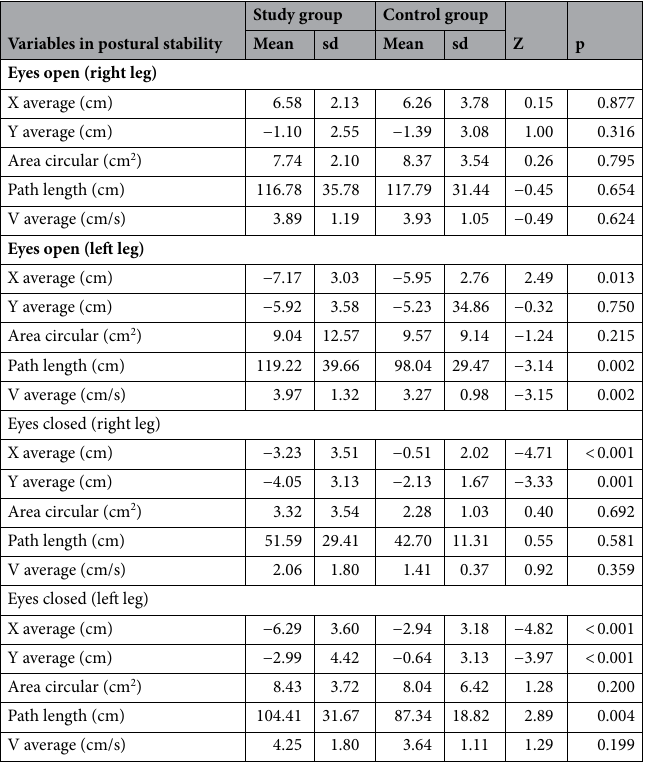
Table 3. Results of postural stability measurement on the platform with single-leg support in study and control groups. Z Mann–Whitney U-test result, sd standard deviation, X average average load point X which determined lateral coordinates X (cm), Y average average load point Y which determined the anterior– posterior coordinates Y (cm), V average average COP velocity (cm/s), p significance level, p < 0.05 reflects statistically significant relationship, p < 0.01 reflects highly significant relationship, p < 0.001 reflects very highly significant